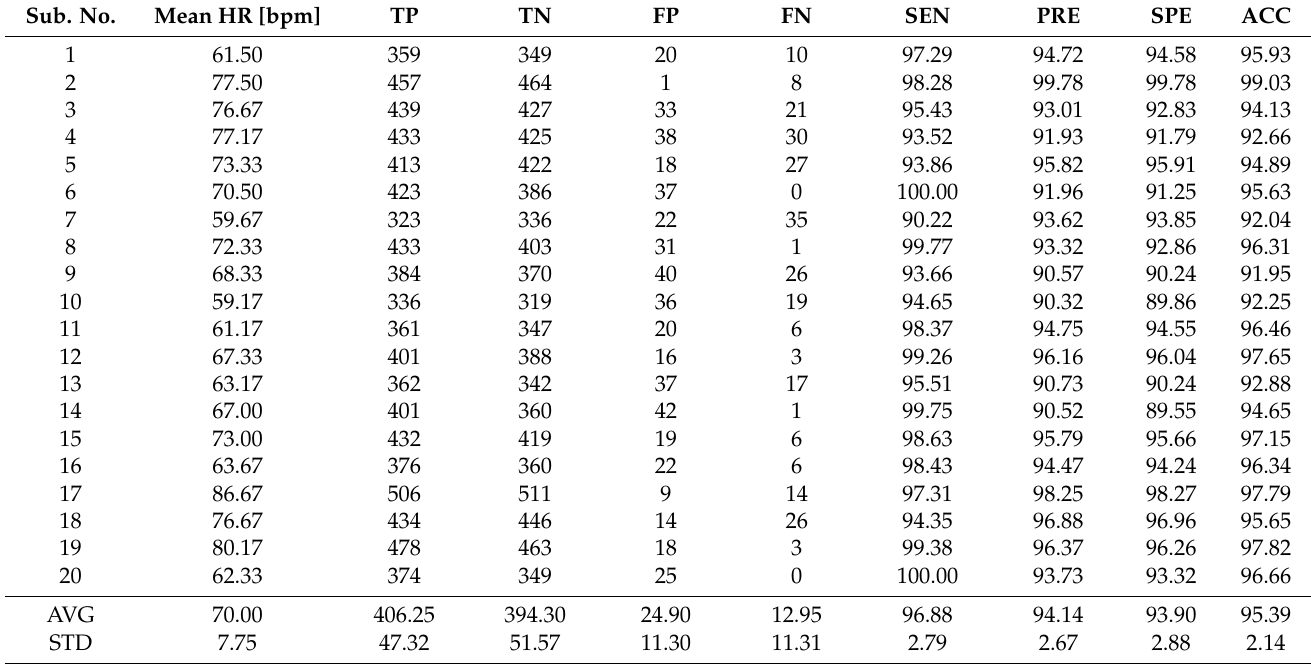
Table 7. Performance of S1 peak detection in Model III.